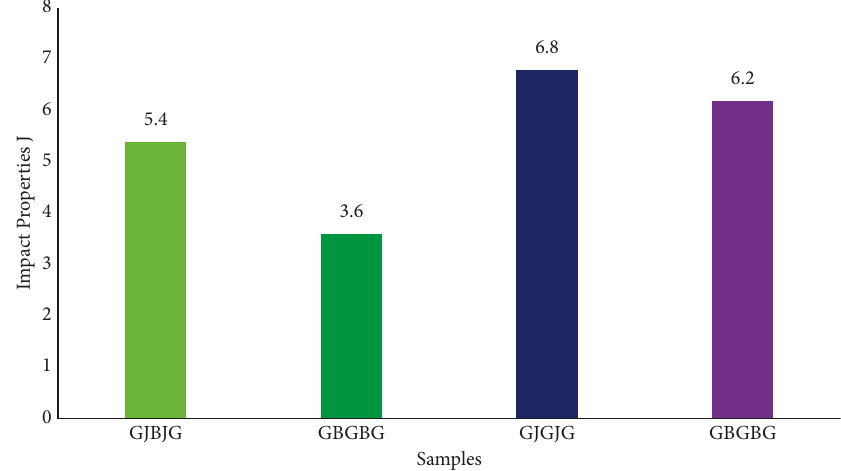
Figure 7: The composites impact